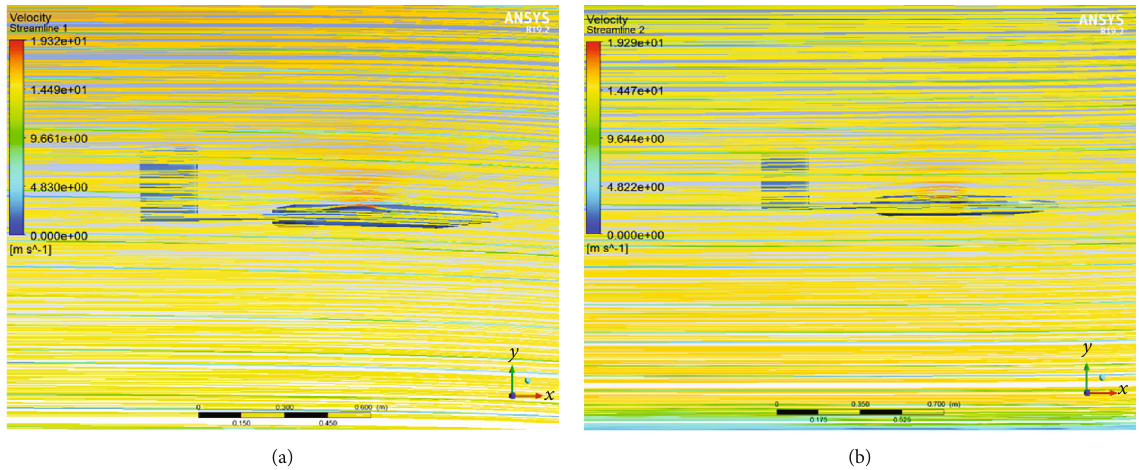
Figure 16: (a) Air fl ow through the aircraft at 5 deg. (b) Air fl ow through the aircraft at -2